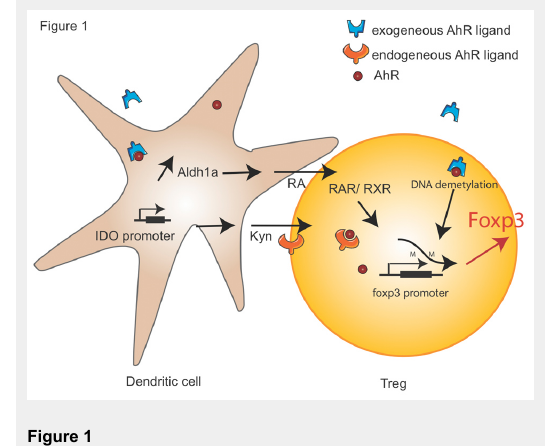
AhR signalling in Tregs. The molecular mechanisms by which AhR promotes Foxp3 + Tregs cell are shown. Exogenous AhR ligand induces tolerogenic DCs by multiple pathways. Firstly, the activation of AhR enhances the expression of Aldh1a1 which drives RA secretion. In T cells, RA binds to RAR and RXRs, which in turn bind to the Foxp3 promoter. Secondly, the activation of AhR induces the formation of Kyn in an IDO-dependant manner in DCs. Kyn further acts as an endogenously AhR ligand and promotes Foxp3 expression. In addition, the activation of AhR mediates partial demethylation of Foxp3 promoter in CD4 + T cells.